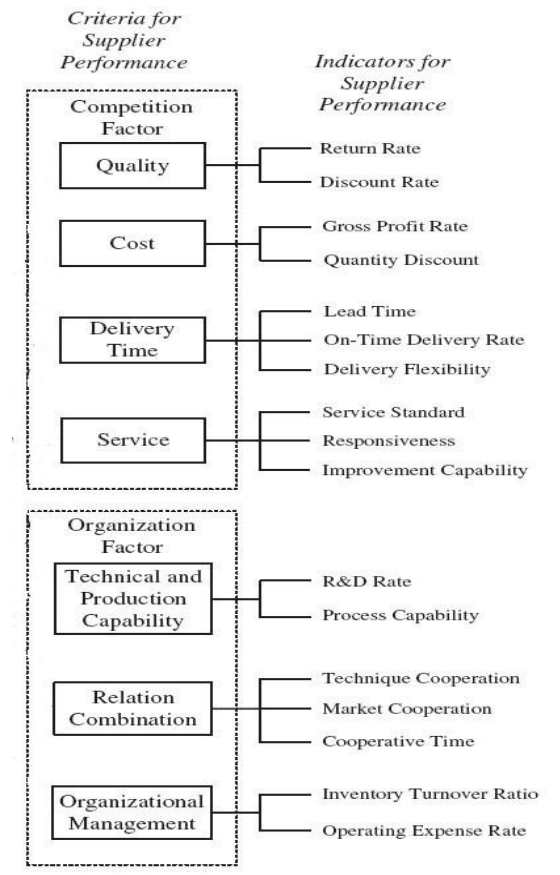
Fig. 4. Supplier performance criteria and indicators (Chen